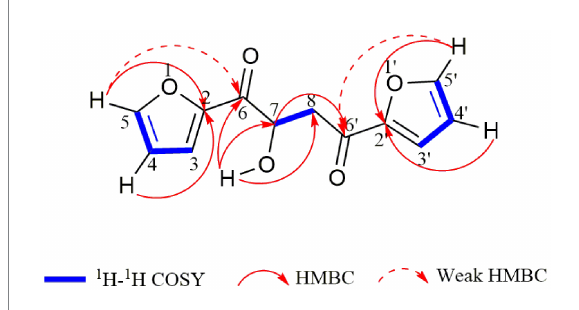
FIGURE 3 1 H- 1 H COSY and HMBC correlations of compound 1 .